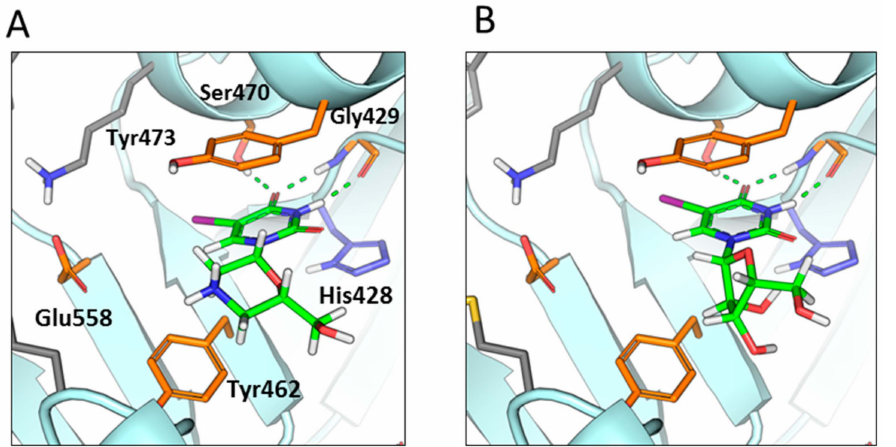
Figure 6. Predicted binding poses of 11IU ( A ) and 5-I-Urd ( B ) bound to the NA binding site of the PARP-2 catalytic domain. Hydrogen bonds are depicted as green dashed lines. Small molecules are shown in green